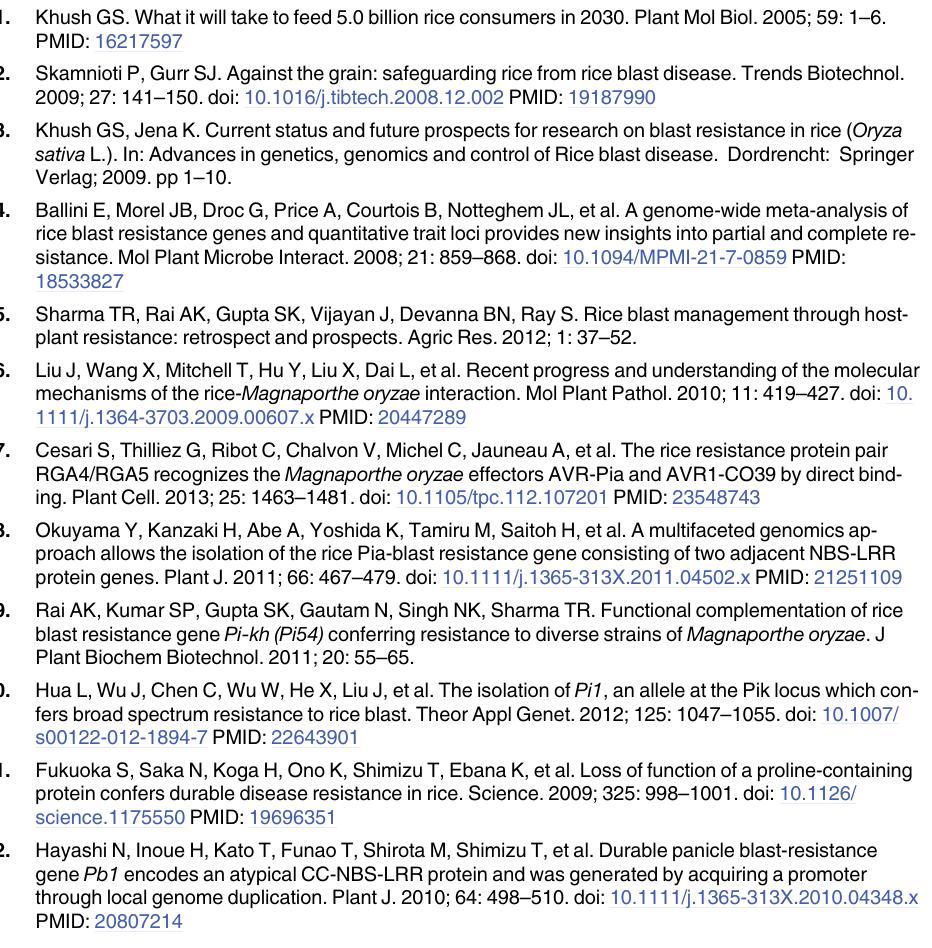
S6 Table. RF values of clusters in indica -type accessions in relation to M . oryzae originating from six provinces, China. S7 Table. RF values of clusters in japonica -type accessions in relation to M . oryzae originat- ing from six provinces,